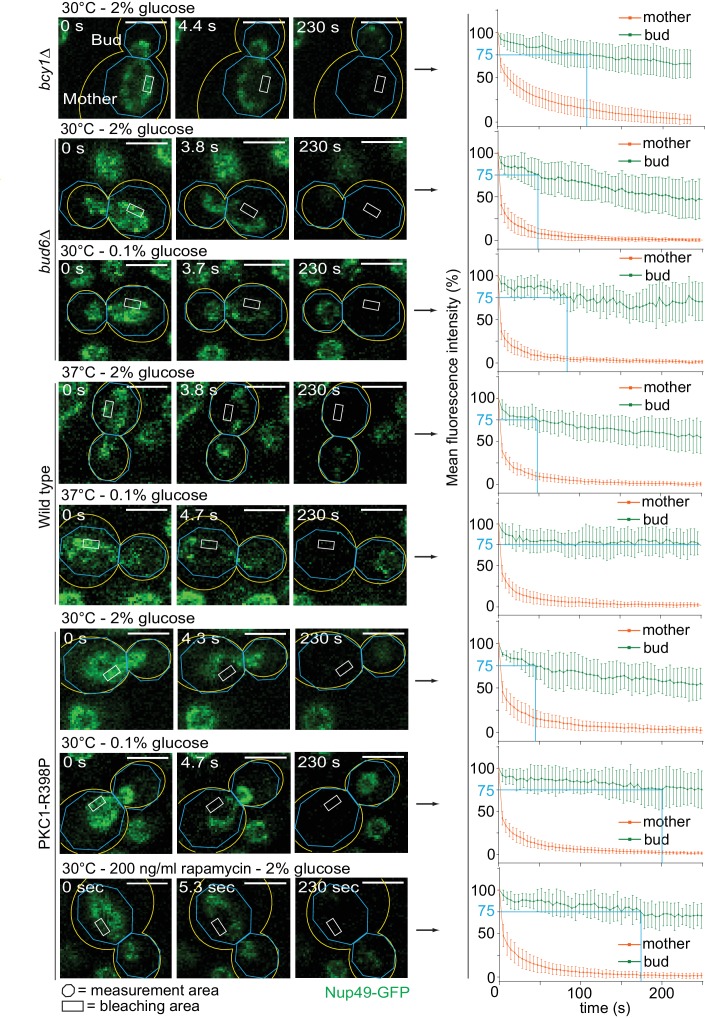
Effect of PKA and Tor1 on the nuclear diffusion barrier in response to heat stress.Representative dividing nuclei (outline of the cell in yellow, scale bar is 3 µm). Areas of constant bleaching and fluorescence measurement are indicated. Graphs show the mean fluorescence intensity over time (±SD, 18 ≤ n ≤ 56 cells per condition). For comparison purposes: the fluorescence intensity profiles of wild-type cells (0.1% glucose at 30°C and 2% glucose at 37°C) and of bud6Δ mutant cells (2% glucose, 30°C) are the same as in Figure 4B.